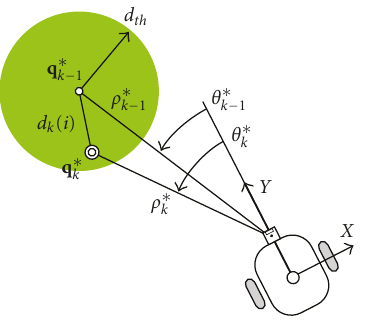
Figure 7: Selection of the goal point for person following.